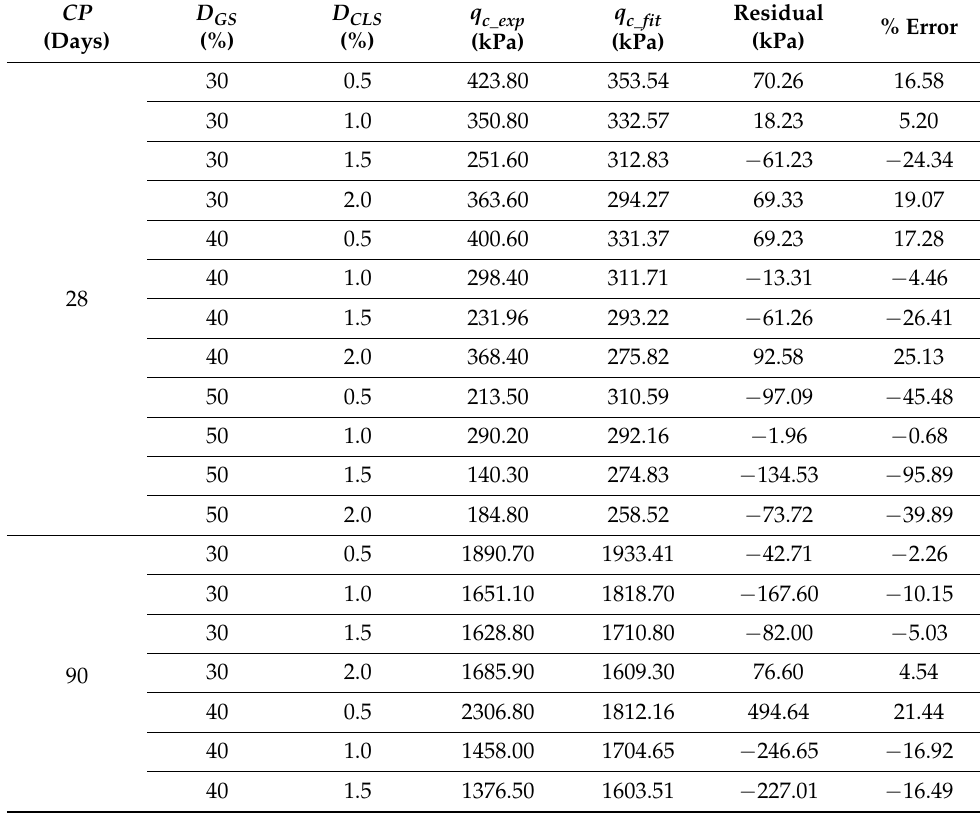
Table 8. The nonlinear equation for the UCS ( q c _ fit ) of treated soil with granite sand (GS) and calcium lignosulphonate (CLS) measured after 28 and 90 days of